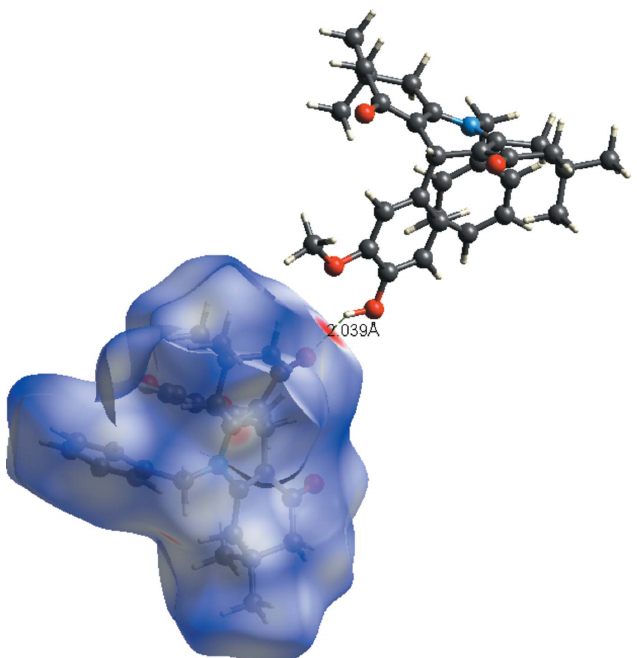
Figure 3 View of the three-dimensional Hirshfeld surface of the title molecule plotted over d norm in the range (cid:3) 0.436 to 1.583 a.u.